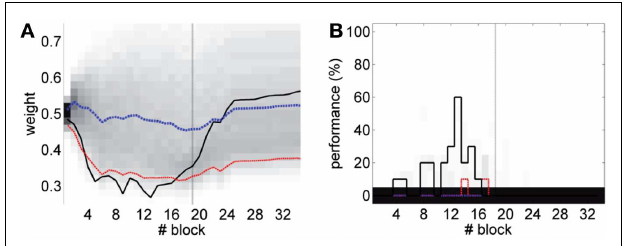
FIGURE 16 | Performance with the adaptive calibration method. (A) Trajectory of the memory parameter w plotted in blocks of 10 trials. Distribution of the performance of the simulations of unpaired CS–US stimulation (grayscale), with mean (dotted blue) and lower 10% (dotted red), for a total of 2500 simulations of 36 blocks.Trajectory of the simulated classical conditioning experiment (solid black), with 18 blocks of acquisition and 18 blocks of extinction.The transition from acquisition to extinction training is marked by a vertical line. (B) Behavioral performance of the same simulations. Percentage of well-timed CRs per block is shown. Results plotted with the same convention as in (A)